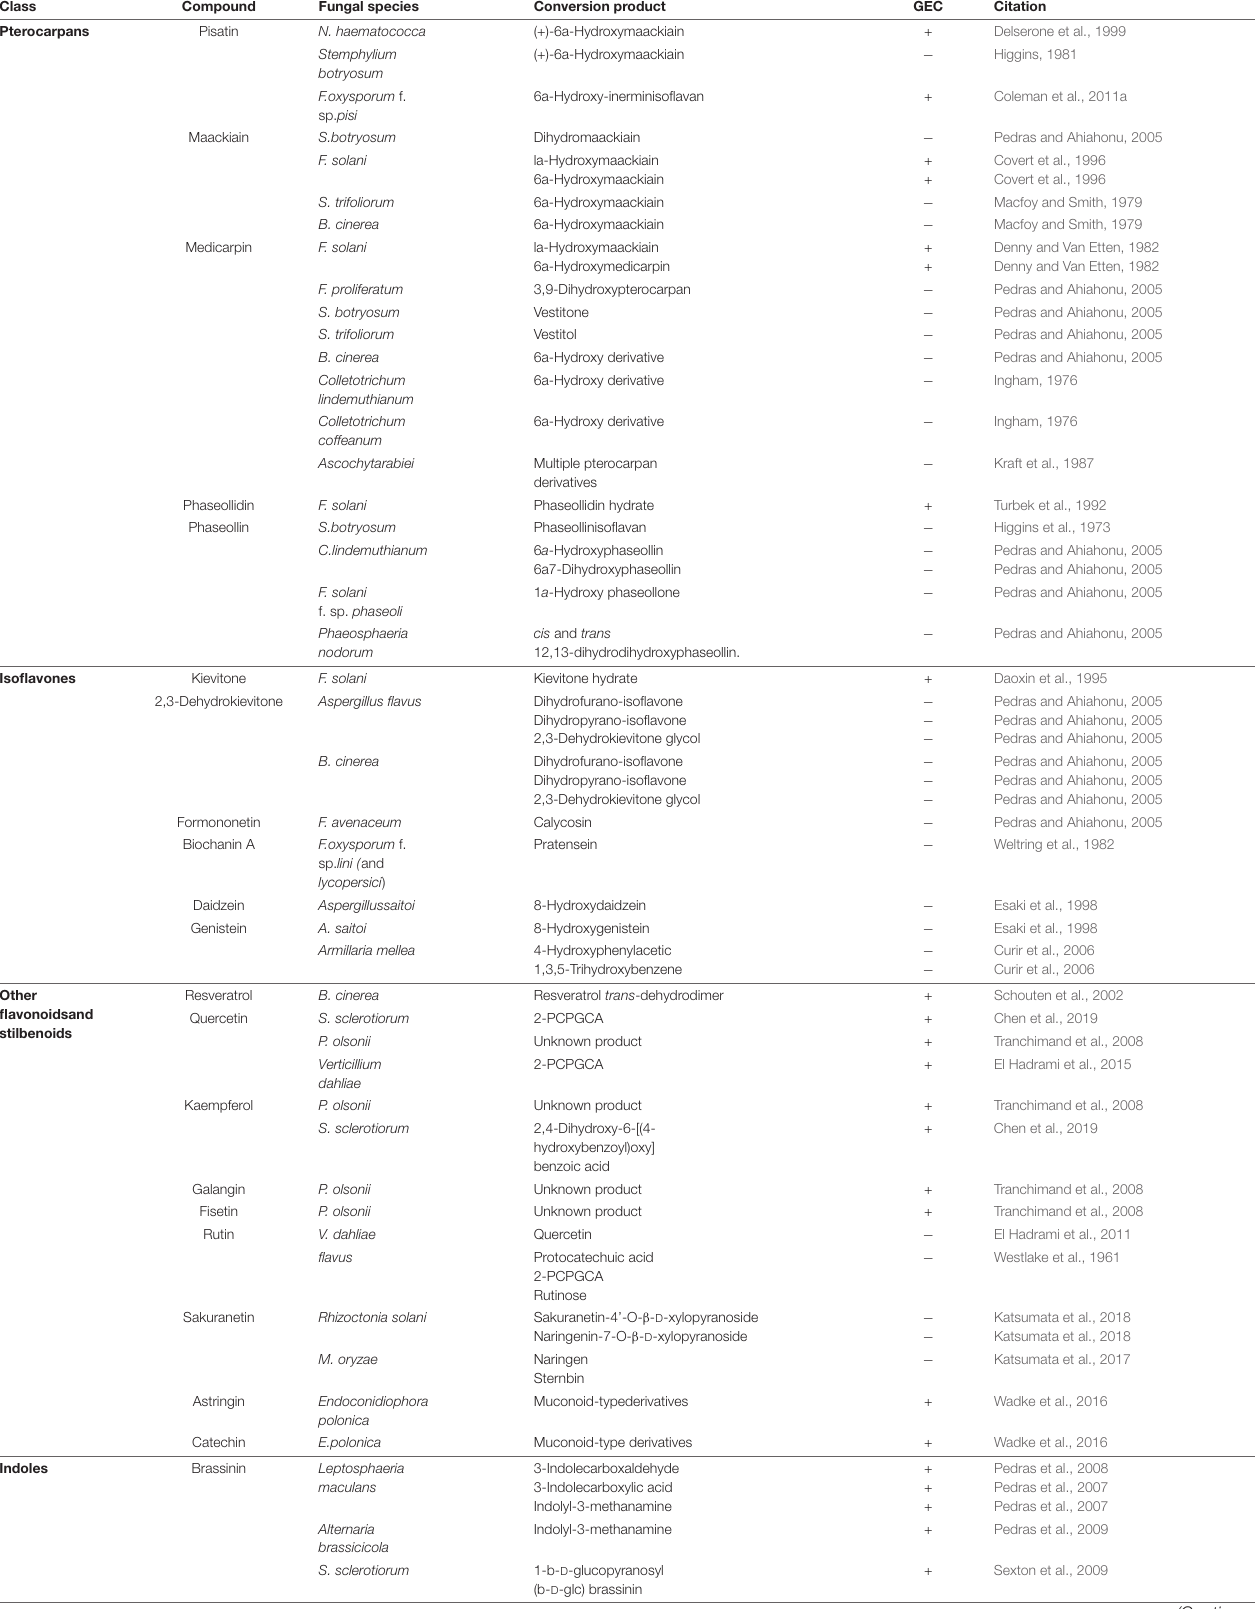
TABLE 1 | Metabolization of inducible PDCs by fungal necrotrophs and